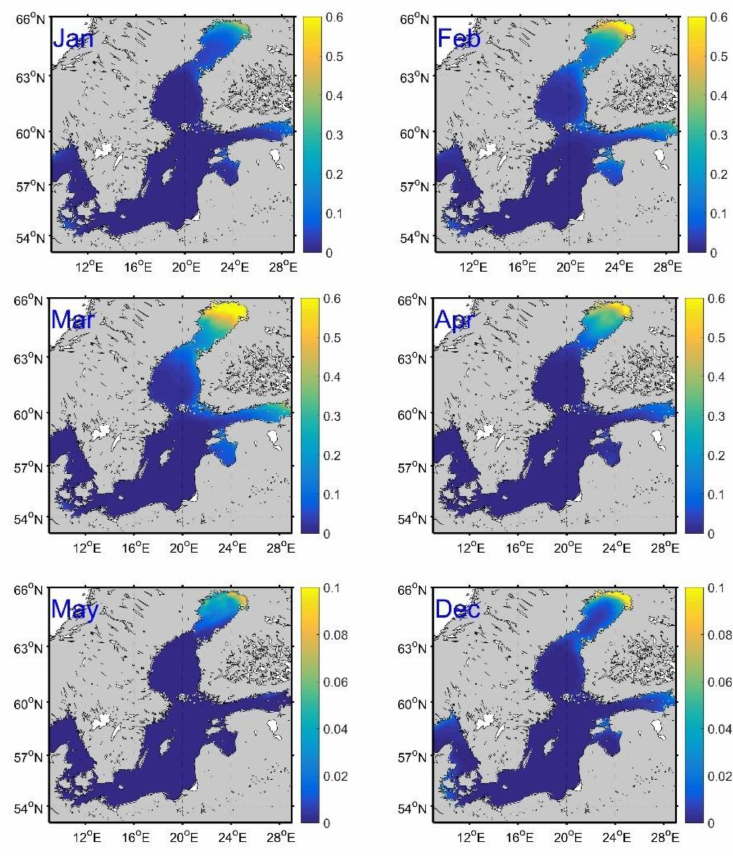
Figure 11. Spatial pattern of monthly sea ice thickness (m) from the SMHI